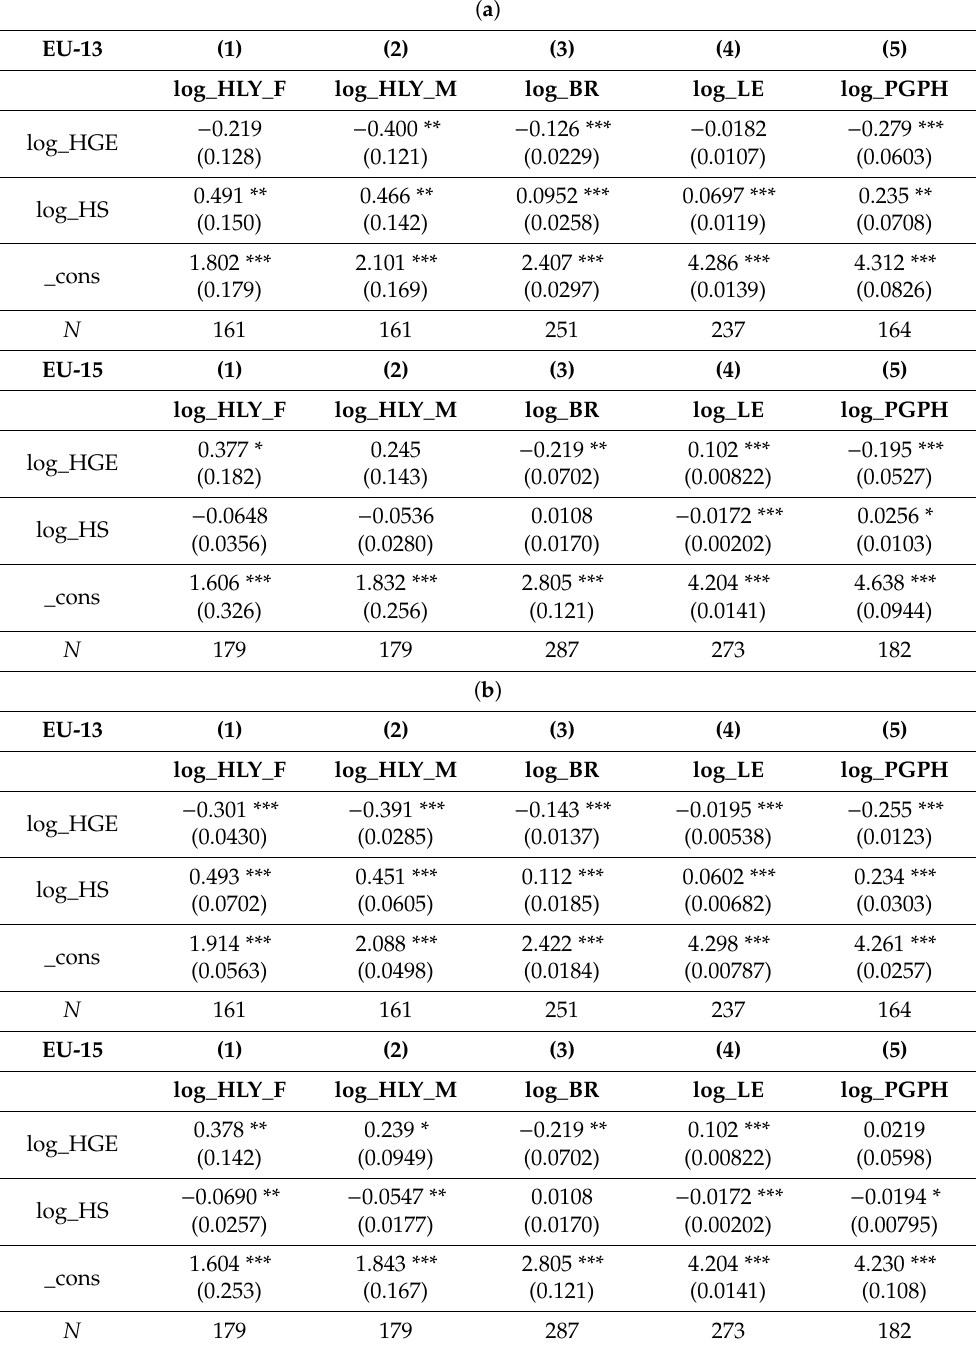
Table A7. (a ) Results of macroeconometric models deployed for H 2 and H 3 , Robust regression (RREG), EU-13 and EU-15, 1995–2017. ( b ) Results of macroeconometric models deployed for H 2 and H 3 , panel-corrected standard errors (PCSE), EU-13 and EU-15,